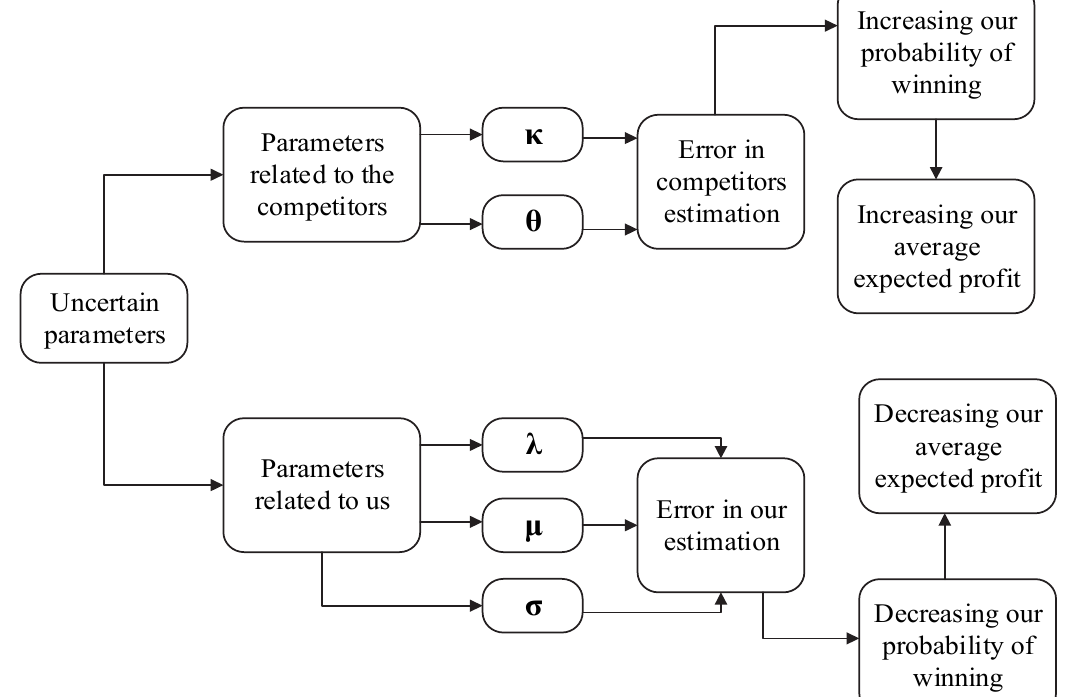
Fig. 5. Uncertain parameters and the effect of their estimation error on the success chance and the awaited benefit. 6. Case study